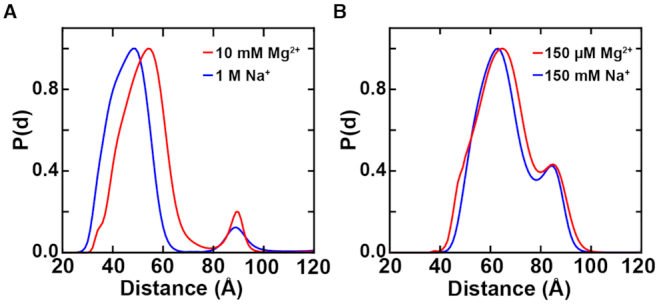
XSI distributions at high and intermediate monovalent salt. (A) Distance distributions for the label pair BH (see Figure 3A) recorded at high divalent salt (red, 10 mM MgCl2 and 30 mM Tris–HCl, pH 7.4) and high monovalent salt (blue, 1 M NaCl and 30 mM Tris–HCl, pH 7.4). (B) Distance distributions for the label pair BH recorded at intermediate divalent salt concentration (red, 150 μM MgCl2 and 30 mM Tris–HCl, pH 7.4) and intermediate monovalent salt (blue, 150 mM NaCl and 30 mM Tris–HCl, pH 7.4).